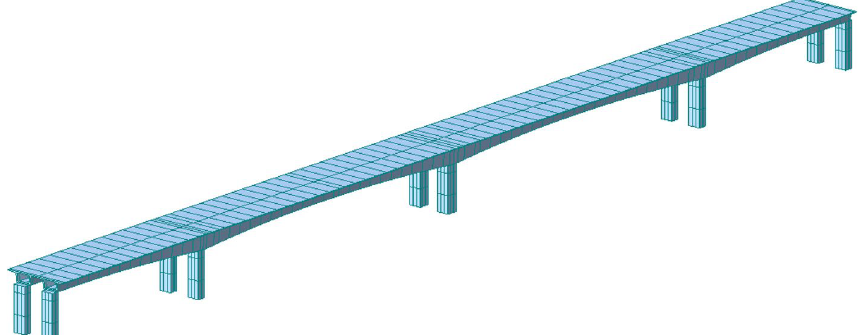
Fig. 5 3D FE model of El-Warrak Bridge in Midas Civil